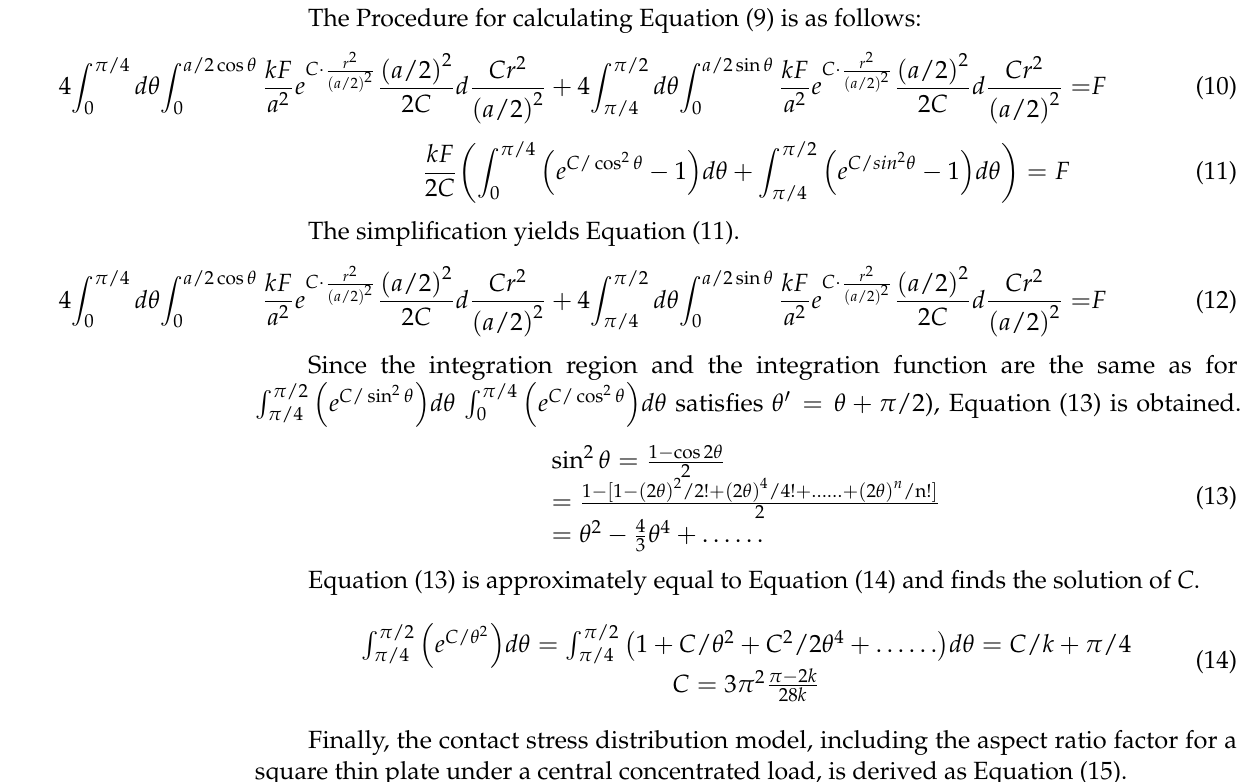
Figure 8. The schematic diagram of integration area.